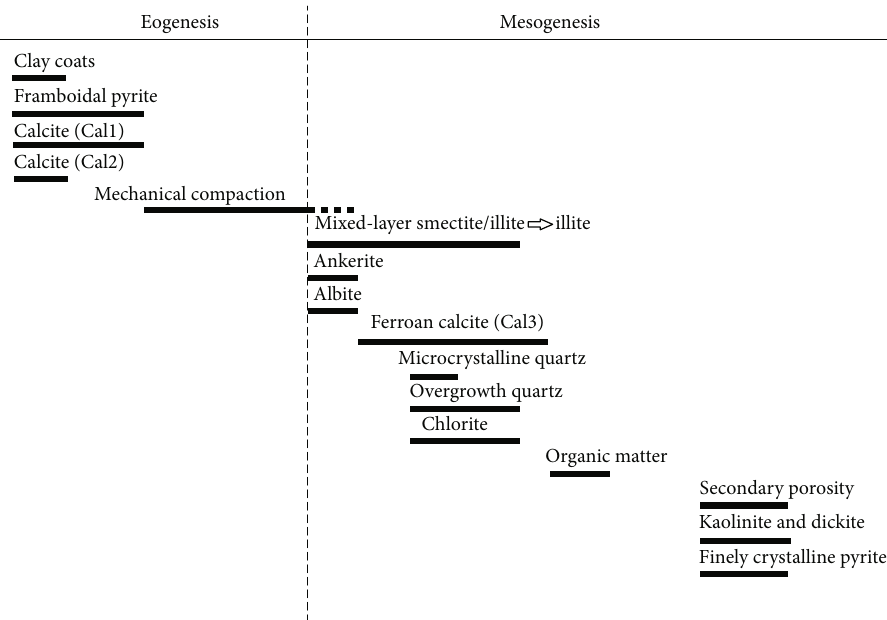
Figure 16: Paragenetic sequence of sandstones in the three studied